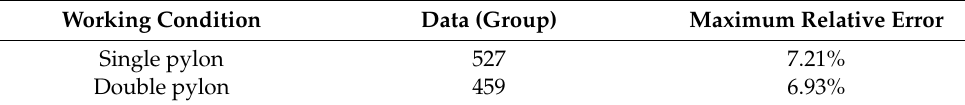
Table 3. Identification effect of different working conditions.